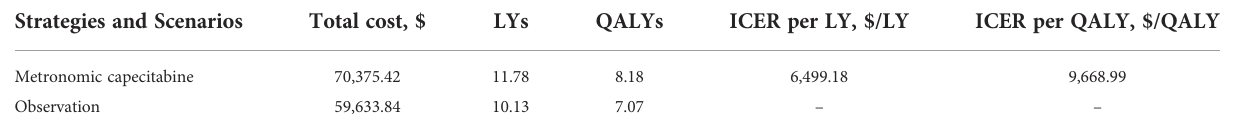
TABLE 3 Baseline